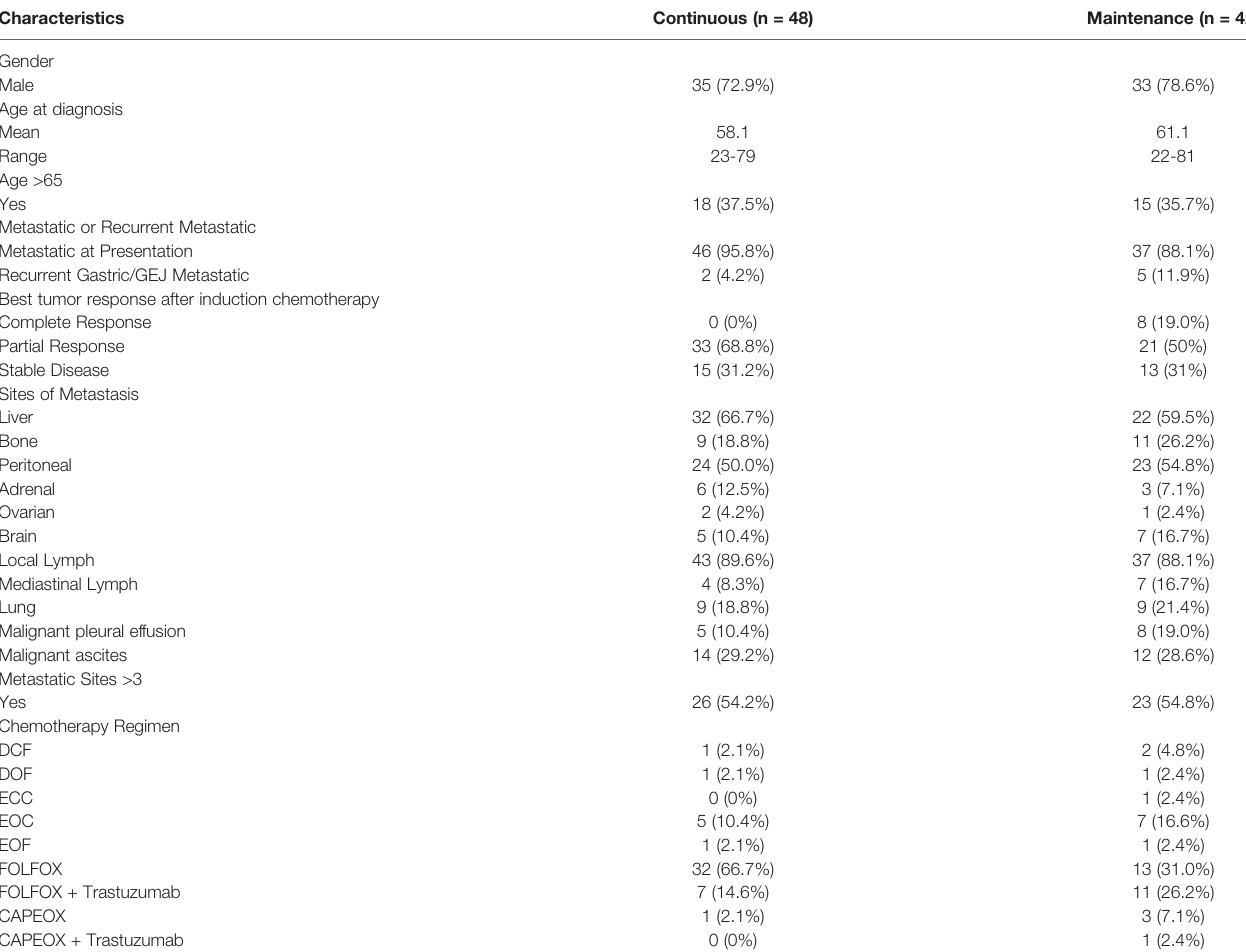
TABLE 1 | Patient characteristics and prognostic variables in maintenance and continuous groups.